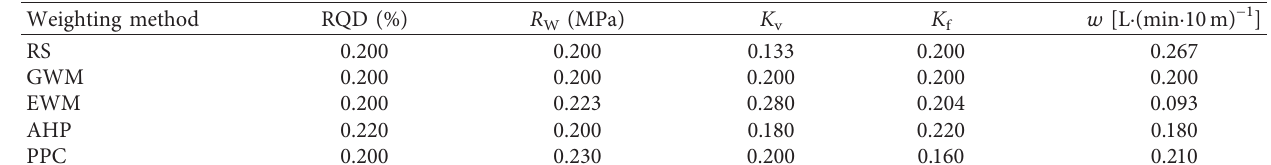
Table 4: Index weight determined by subjective and objective weighting methods.